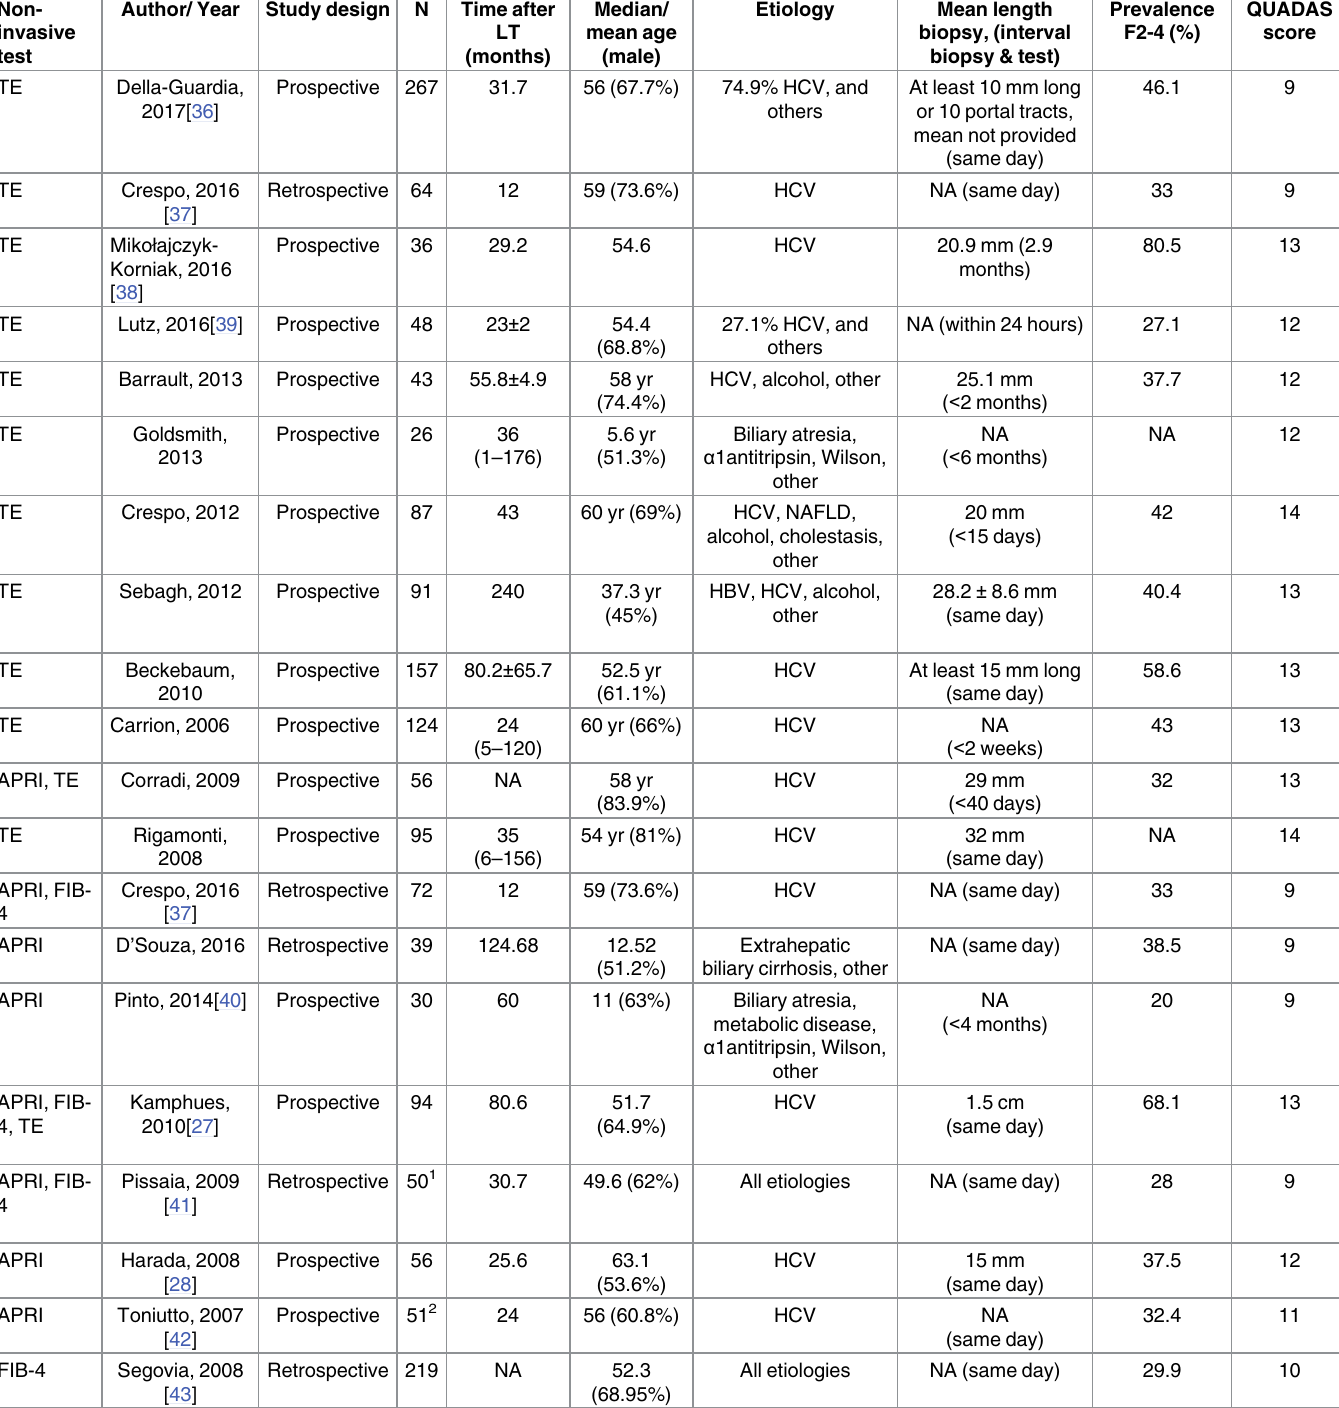
Legend: TE: transient elastography, APRI: AST-to-platelet ratio index, FIB-4: Fibrosis score 4; NA, not available. 1 94 biopsies 2 102